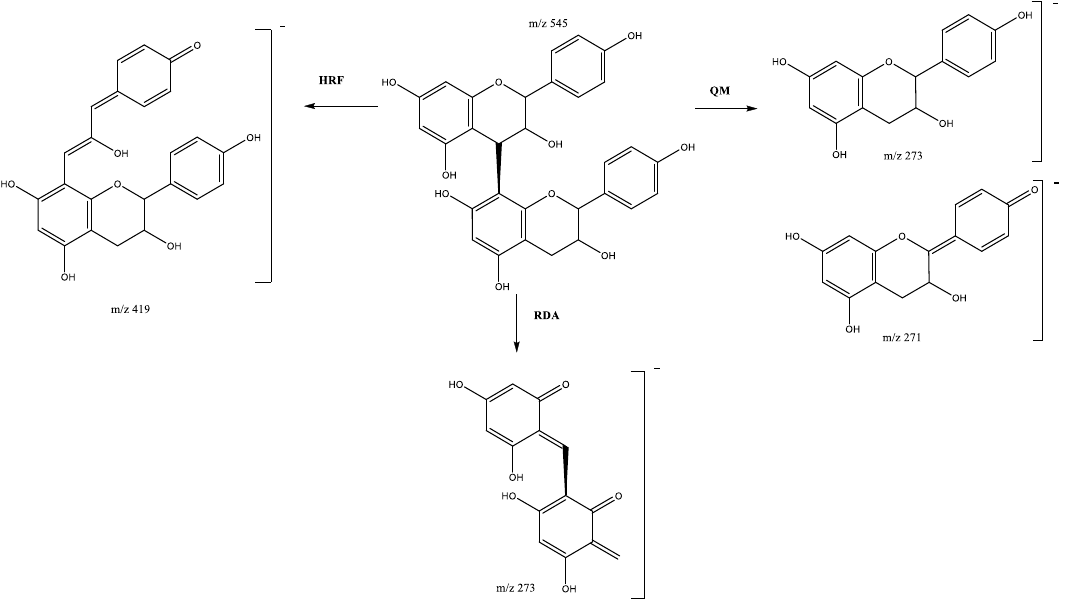
Figure 4. Propelargonidin (epi)afzelechin dimers fragmentation pathway. Four propelargonidin mixed dimers composed of (epi)afzelechin and (epi)catechin units are present in peaks 11 (Rt = 12.62 min), 16 (Rt = 13.68 min), 22 (Rt = 15.63 min) and 32 (Rt = 17.50 min), which show [M-H] - at m / z 561.1416 (C 30 H 25 O 11 ). As shown in Figure